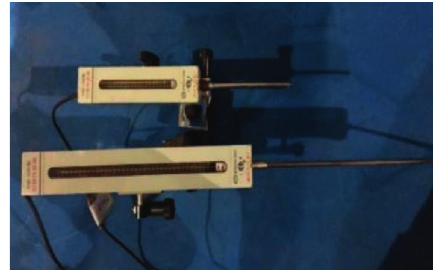
Figure 10: The displacement sensor (YWD).